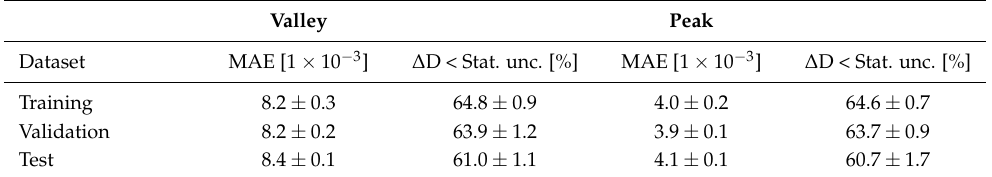
Table 1. Average MAE and fraction of voxels with an absolute dose difference ( ∆ D) between MC and ML calculation of less than 1 σ , computed for the peak and valley predictions. The datasets derive from the MC training, validation and testing. The mean MAEs and associated standard errors are calculated from the MAEs obtained for the augmented data of the 16 rats (10 for training, 3 for validation and 3 for testing). For the voxel fractions (second and forth columns), the reported mean values and standard deviations are calculated considering all the datasets used in the various cases under study, determining the mean value and standard deviation from the individual distributions of each dataset represented in Figures 8c and 9c for an exemplary